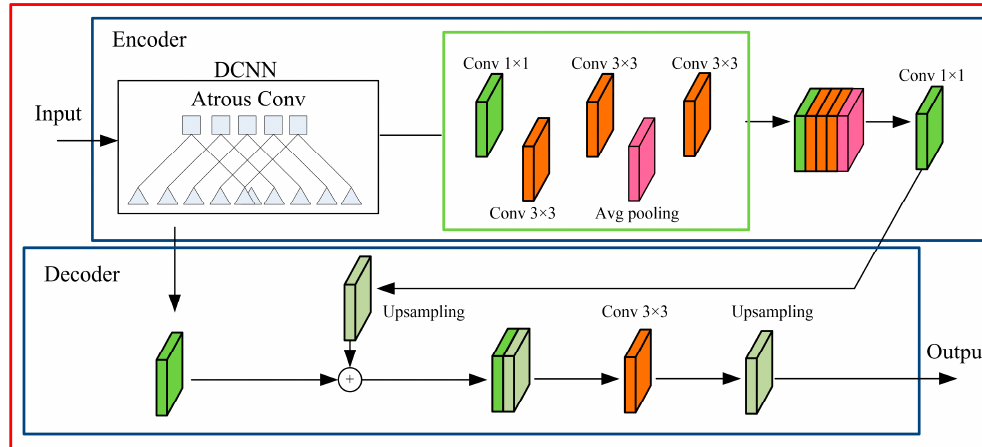
Figure 2. DeeplabV3+ network.